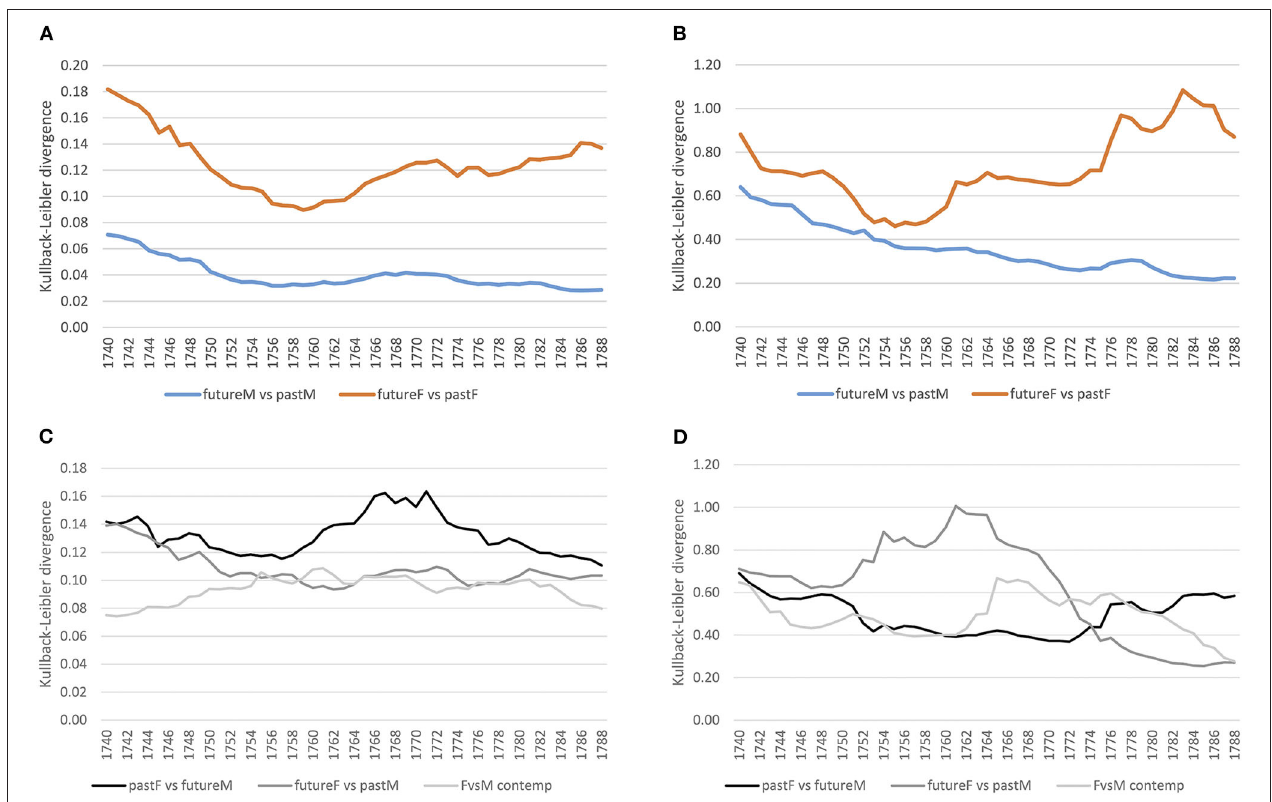
FIGURE 5 | Gender distinguished, diachronic and contemporary models (court vs. letter) at the lexical level (word-unigram). (A) Court: within gender comparison. (B) Letter: within gender comparison. (C) Court: diachronic and contemporary comparison. (D) Letter: diachronic and contemporary comparison.